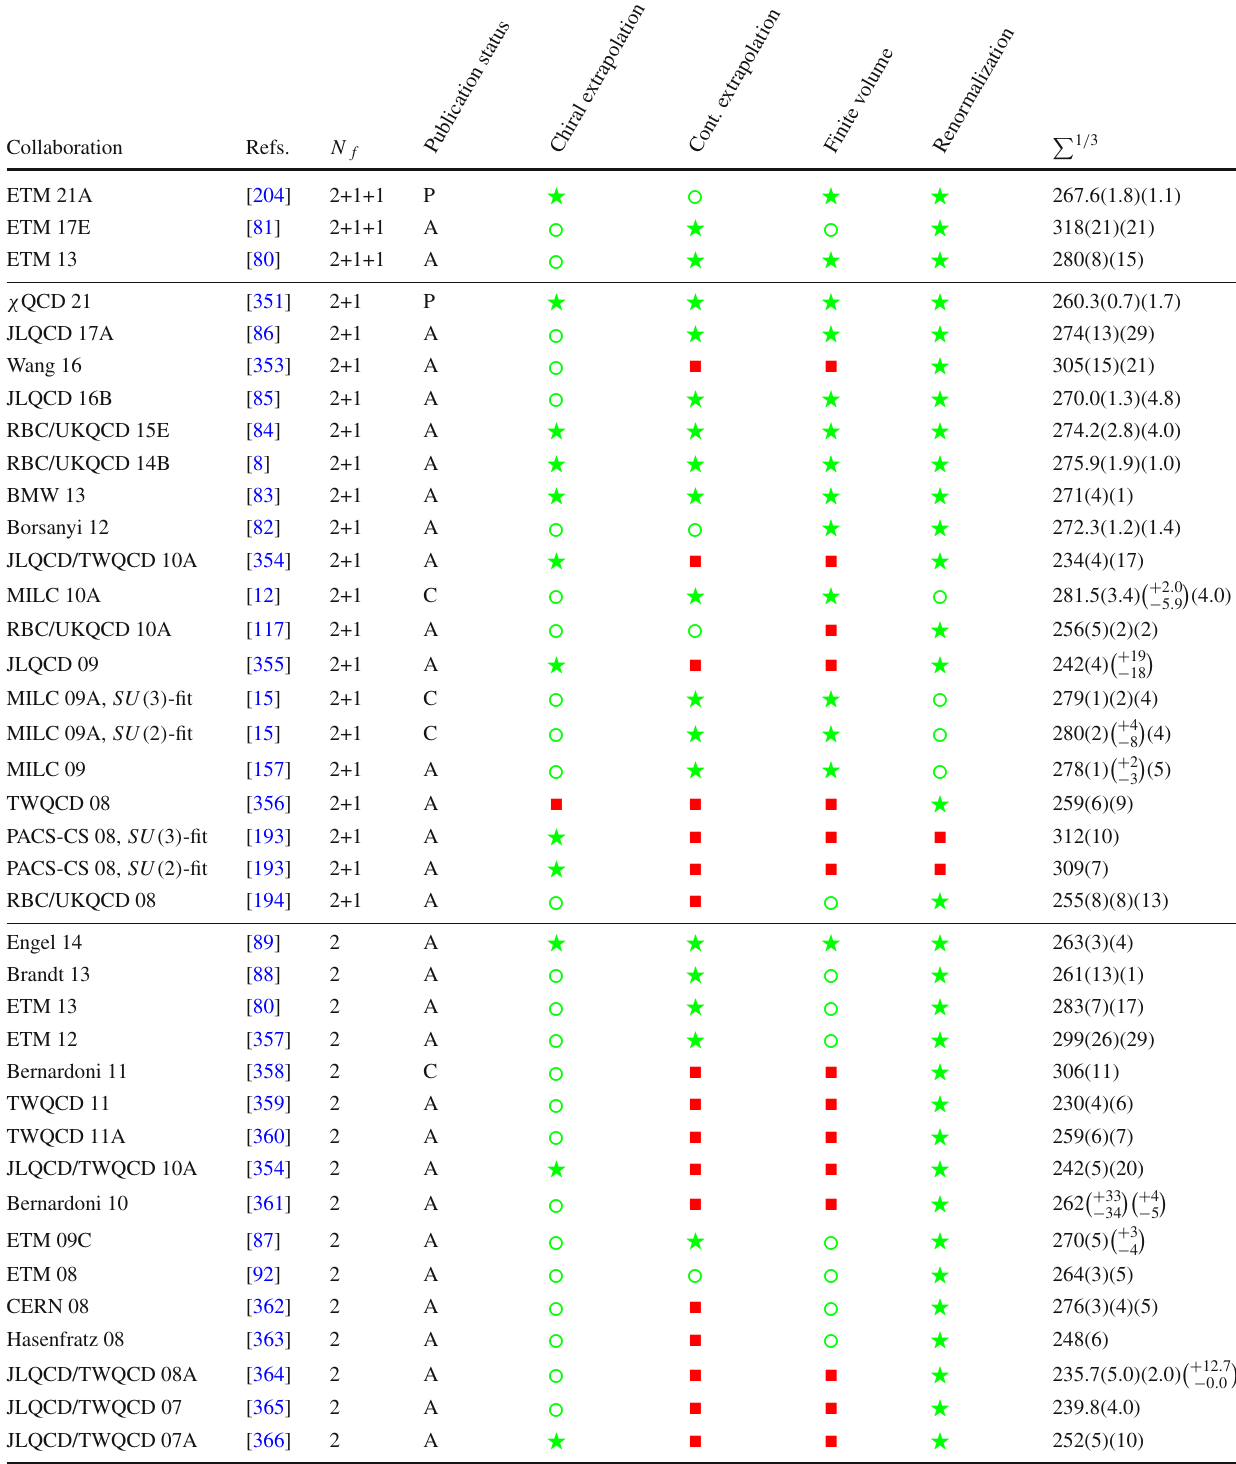
(cid:17)¯ uu (cid:18) in MeV units, in the MS-scheme, at the renormalization scale u , m d → 0 = 0 . 48 ( 2 ) fm [116,367,368], with this error 0 units were converted on the basis of r 0